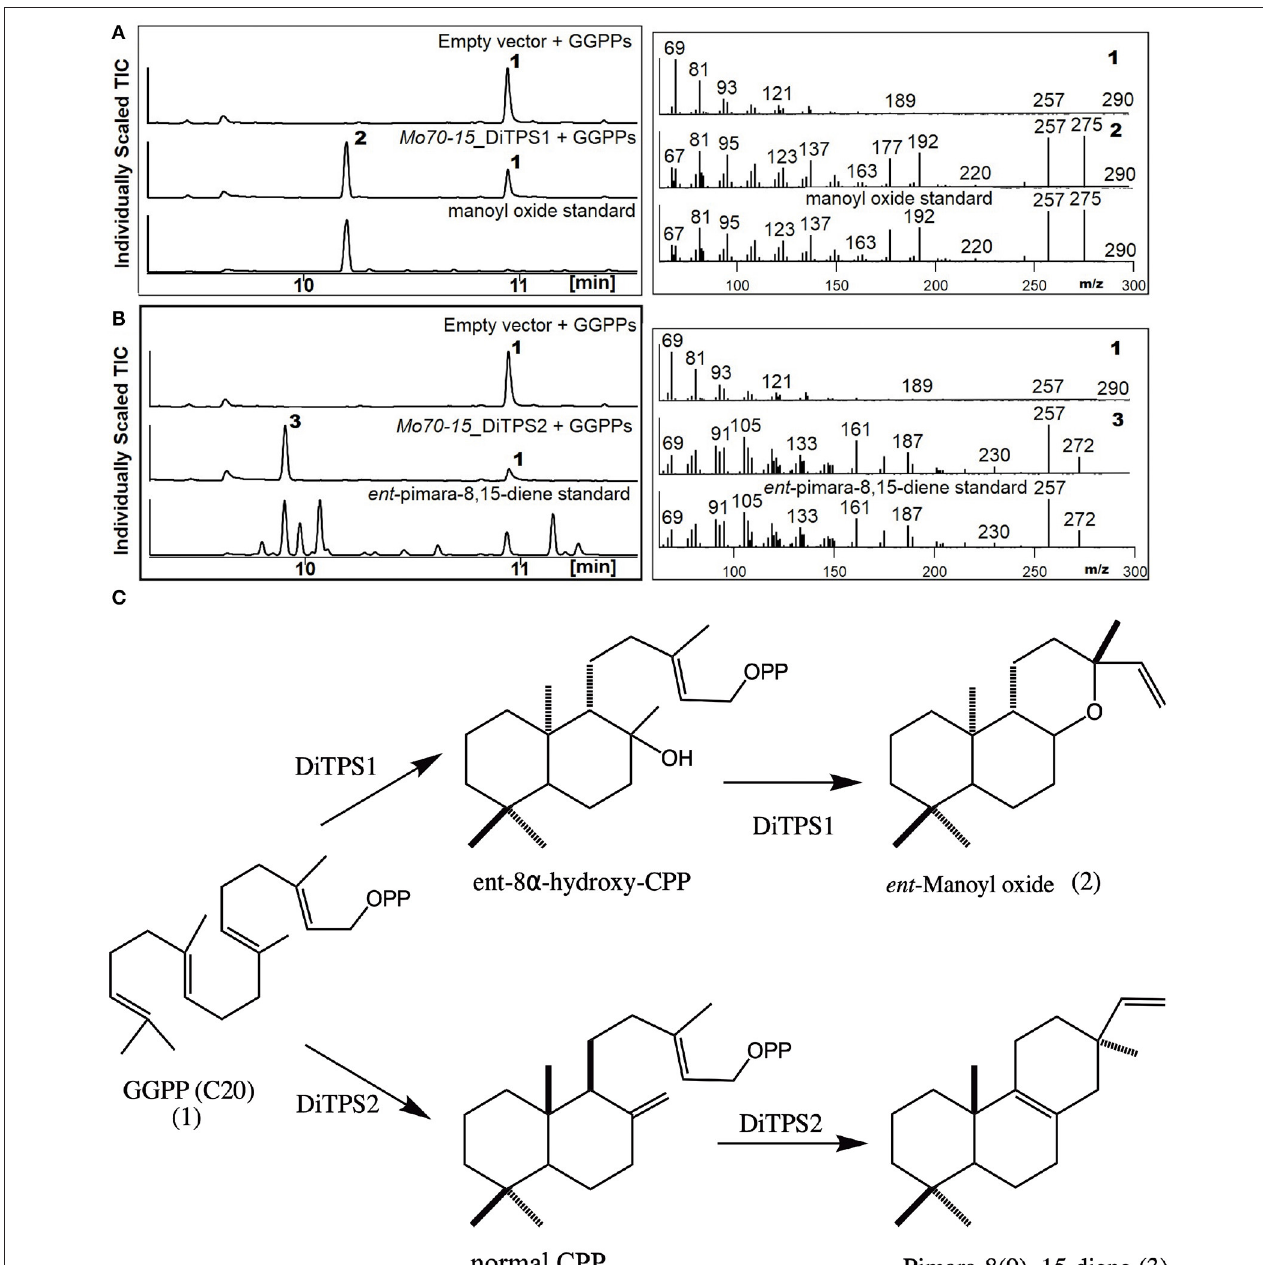
FIGURE 3 | Biosynthesis of labdane diterpenes by M. oryzae . Analysis of resultant products by GC-MS of DiTPS co-expressed in E. coli optimized for the expression of diterpenes. The empty vector co-expressed with GGPP synthase was used as control and products verified by comparison to authentic standards. Chromatograms and mass spectra from GC-MS analysis of (A) DiTPS1 (B) DiTPS2 [ ent -pimara8(9), 15-diene was used to confirm the metabolite followed by combinatorial expression with stereospecific enzymes to determine the intermediate stereochemistry] (C) Structures of the intermediate class II and class I products produced by Magnaporthe